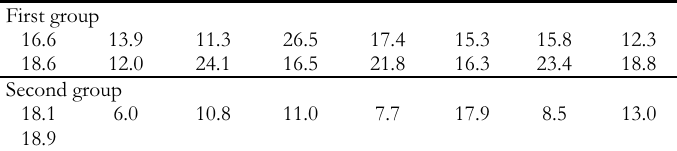
Lung destruction index scores